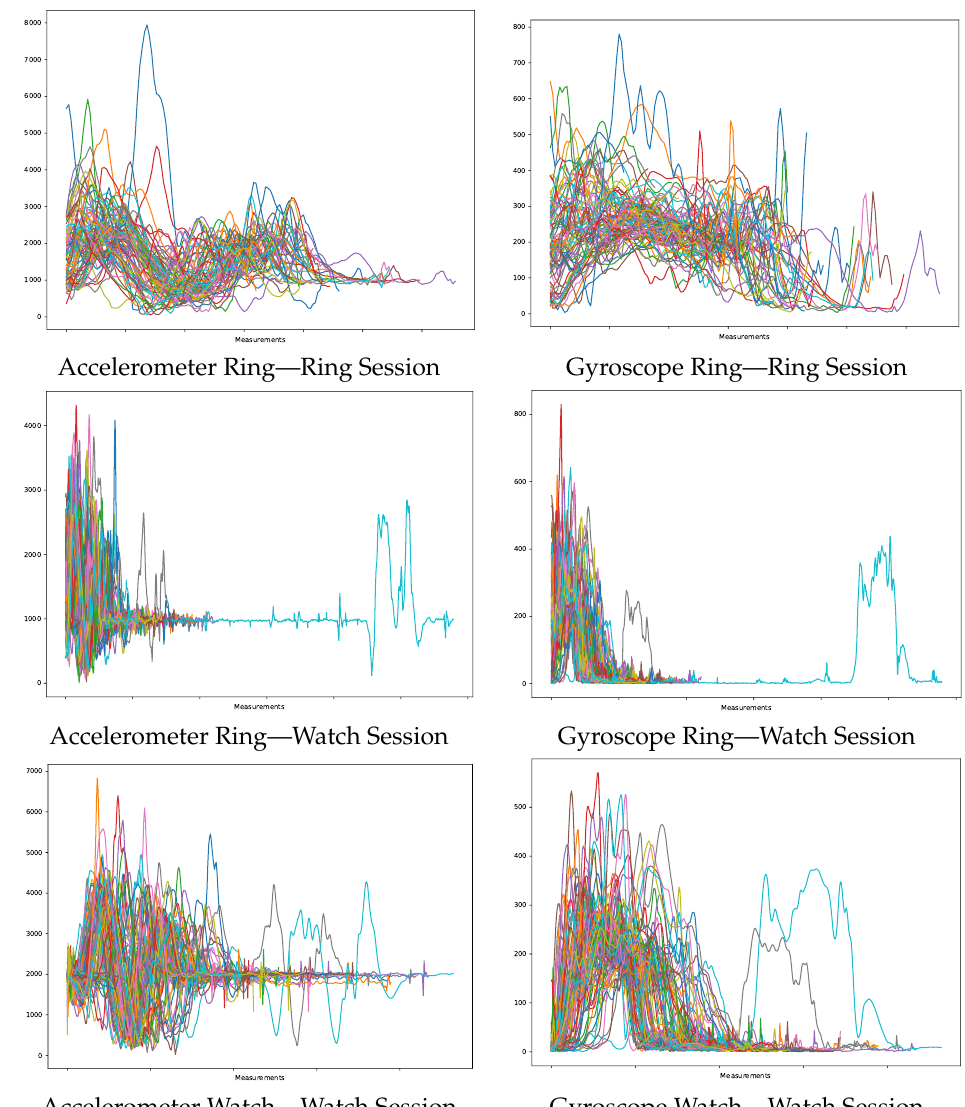
Figure 9. Unprocessed magnitude data for the Circle Clockwise gesture. The two columns contrapose accelerometer and gyroscope data and each row shows data originating from a different session. The data contain a few outliers and each signal is scaled differently. Additionally, some signals are shifted in time and the data contain high frequency